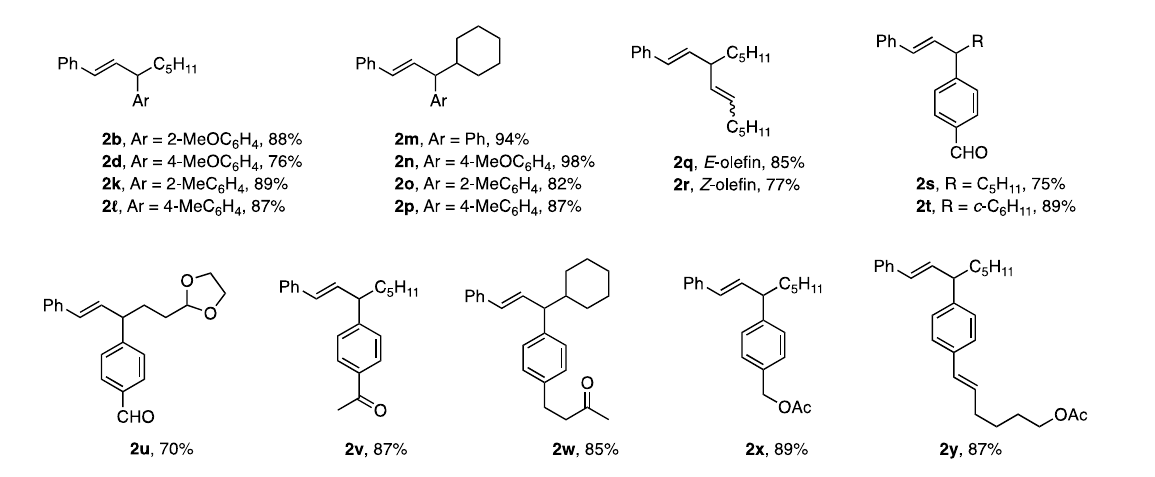
Figure 3. Coupling products derived from zinc borates. Catalysts 2023 , 12 , x FOR PEER REVIEW Figure 2. Zinc borates prepared for allylic coupling reaction. Figure 2. Zinc borates prepared for allylic coupling reaction.